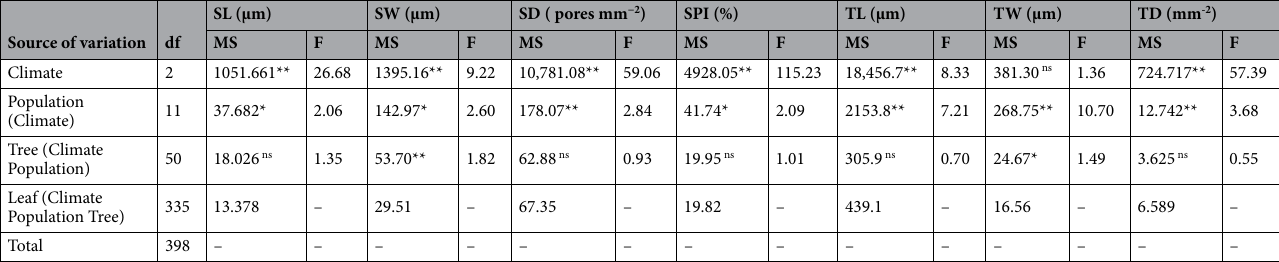
Table 2. Leaf anatomical traits in ANOVA hierarchical model between three different climates. Stomata length (SL), stomata width (SW), stomatal density (SD), stomatal pore index (SPI), trichome length (TL), trichome width (TW) and trichome density (TD). * P < 0.05; ** P < 0.01, ns: